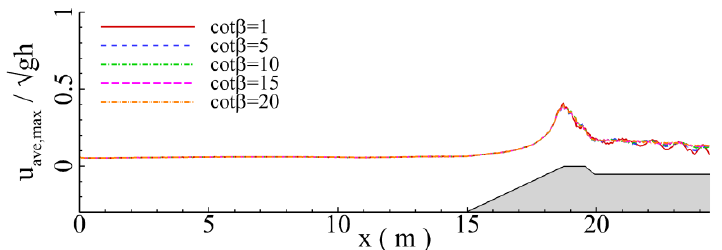
Figure 51. Space distributions of the local maximum depth-averaged velocity.